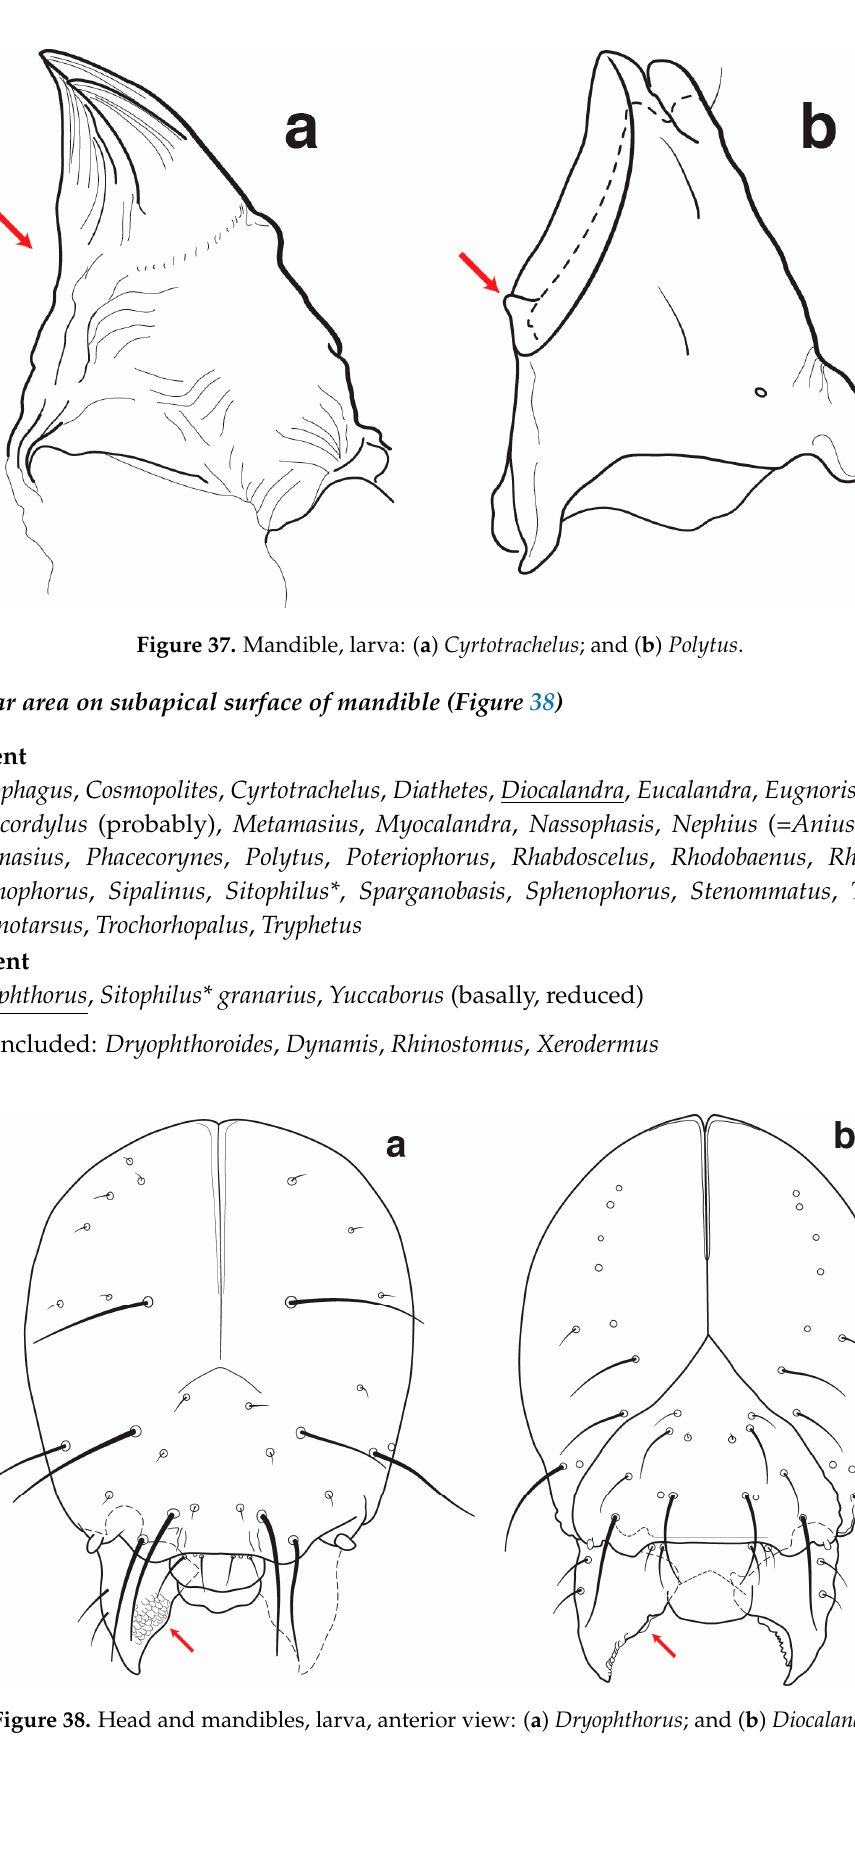
Figure 38. Head and mandibles, larva, anterior view: ( a ) Dryophthorus ; and ( b ) Diocalandra .